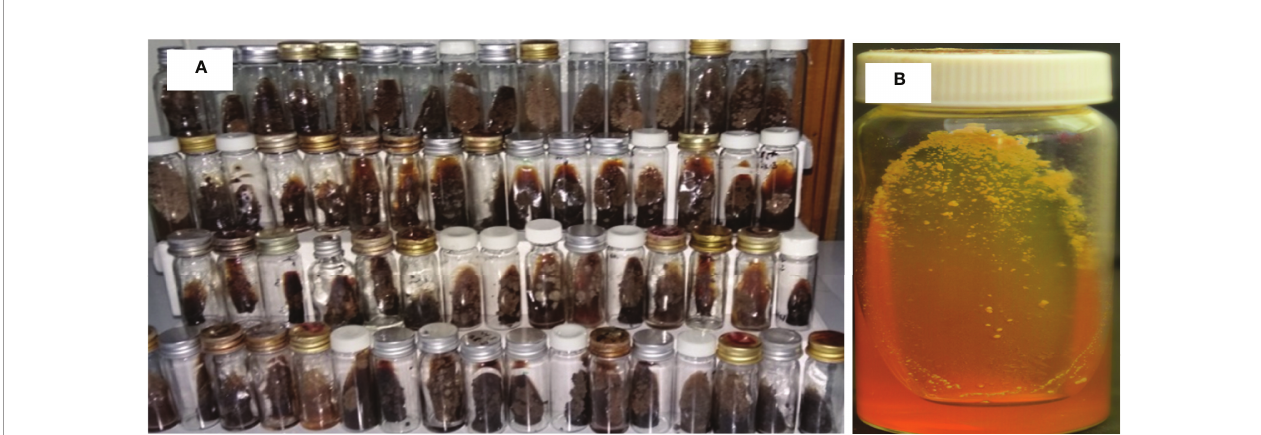
FIGURE 2 | Mycelial and yeast colonies of H. capsulatum var. farciminosum isolated from epizootic lymphangitis cases of horses in central Ethiopia. (A) Mycelial colonies on 2.5% glycerol enriched Sabouraud Dextrose Agar grown at 26°C after 4 – 8 weeks of incubation. The slants show pure mycelial colonies that are abundant, gray/white in color at the early stage but becoming brown as they are aging. (B) Yeast colonies grown on the Brain Heart Infusion Agar at 37°C after incubation for 4 – 8 weeks. The yeast colonies are small in size and whitish gray in color.